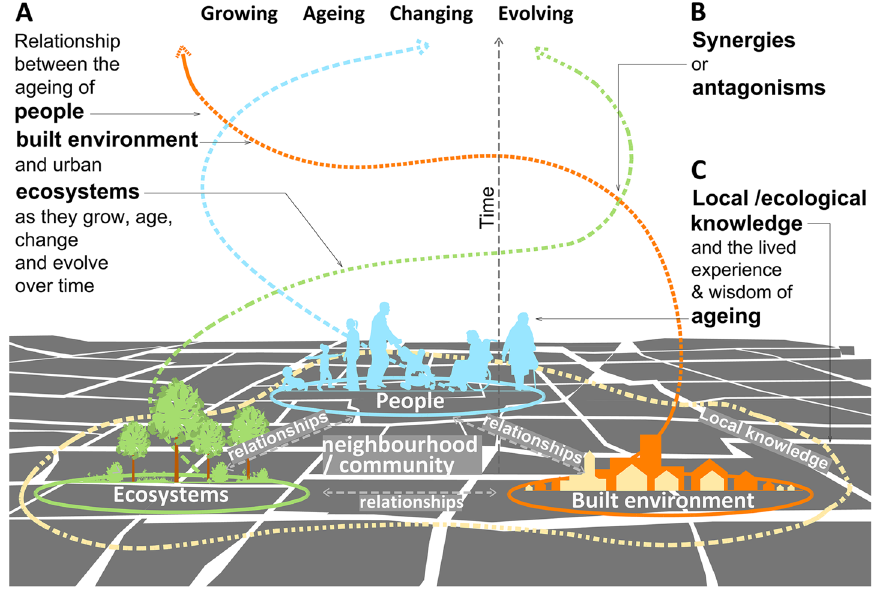
Fig. 1 Integrated approach to ( A ) people, urban environment, and ecosystems, ( B ) synergies or antagonisms, and ( C ) local knowledge and wisdom of